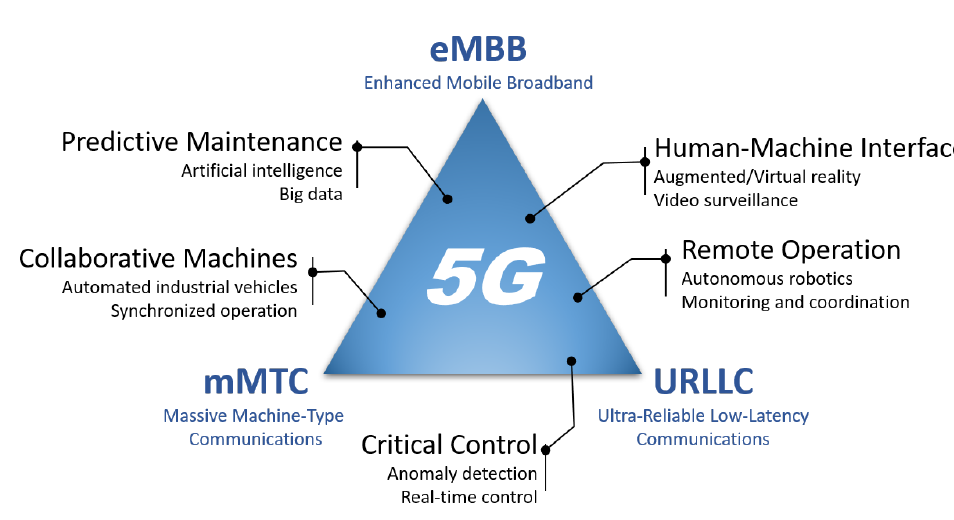
Figure 6. 5G categories for smart manufacturing use